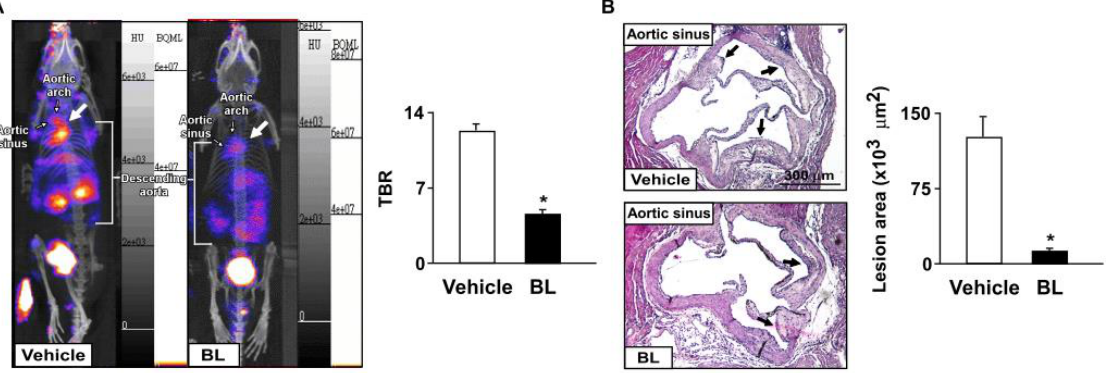
Figure 3. Bromelain attenuates atherosclerosis lesion size in apoe −/− mice . Male apoe −/− mice were orally administered bromelain (BL, 20 mg/kg/day) or vehicle (PBS) for four weeks. ( A ) The highest target/background ratio (TBR) of [68Ga]-APD on atherosclerotic aortas. ( B ) Atherosclerotic lesions at aortic roots, highlighted by H&E staining. Scale bar = 300 µm. Atherosclerotic lesions at the aortic sinus were indicated by arrows. * p < 0.05 vs. vehicle-treated apoe −/− mice.